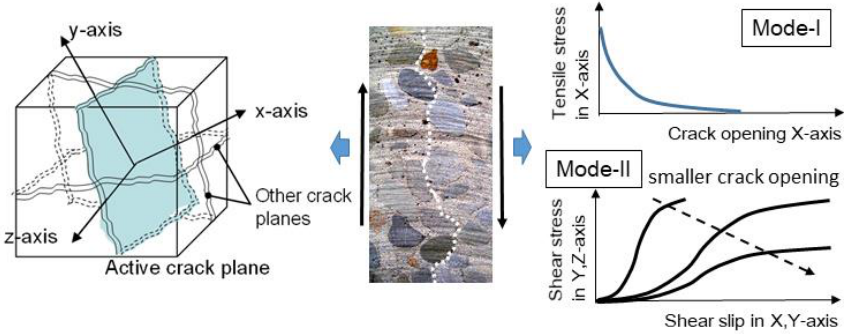
Figure 2. Tension and shear stress transfer across crack planes of concrete.